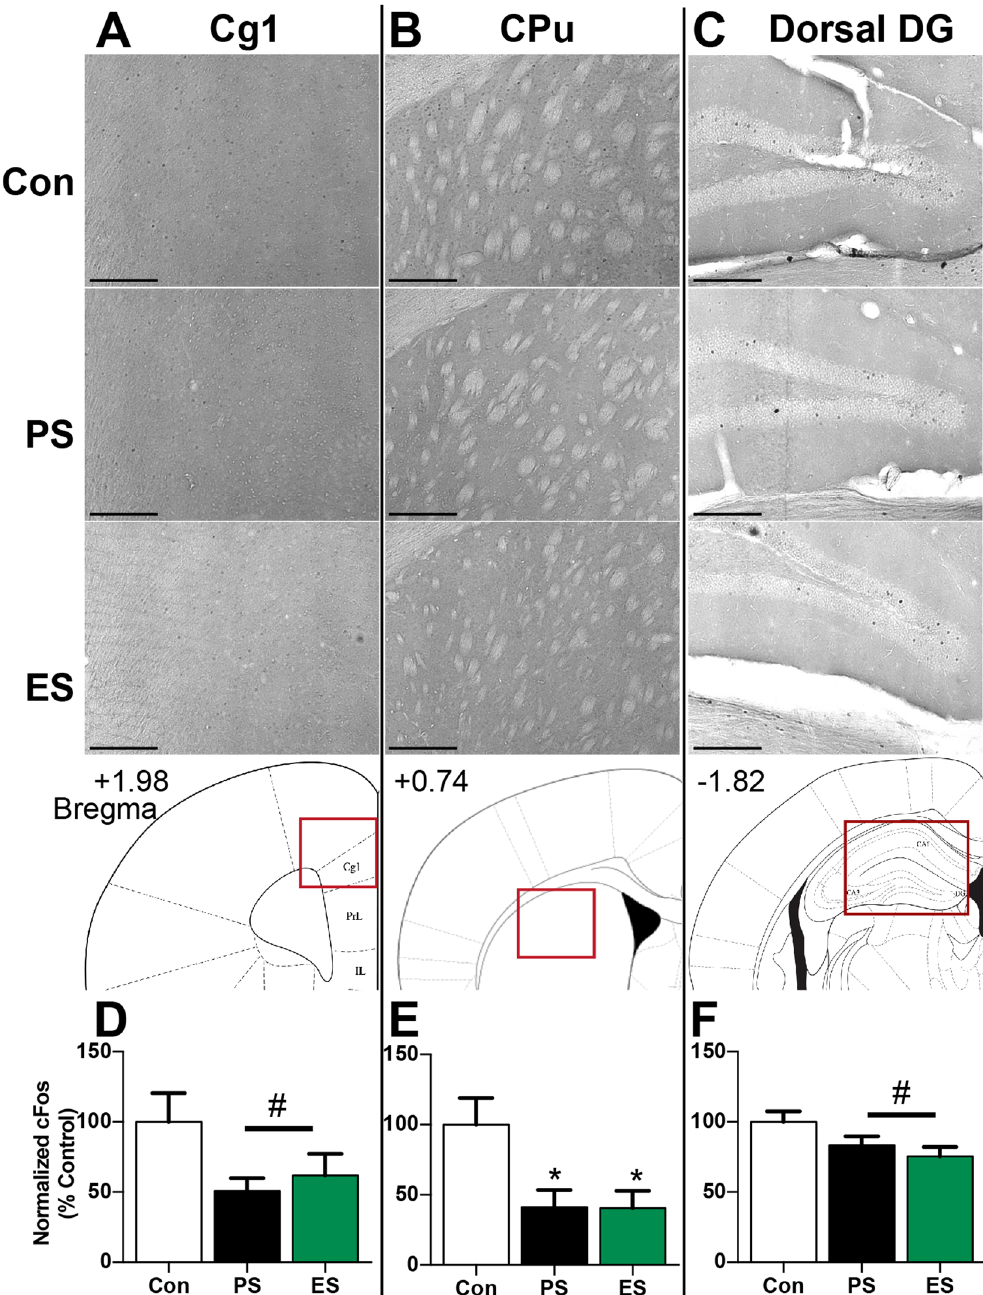
Figure 3. CSDS decreases the number cFos-positive cells in select brain regions. Top panel: Representative images of cFos-positive nuclei visualized by DAB-staining in control (Con), physical stress (PS), and emotional stress (ES) mice in ( A ) cingulate cortex (Cg1), ( B ) caudate putamen (CPu), ( C ) Dorsal dentate gyrus (DG) (Scale bar: 200 μ m). Schematics of the location of each brain region (red box) within a coronal slice are depicted below (adapted from ref. 36). ( D – F ) Quantification of the number of cFos-positive nuclei, displayed as percent of control. n = 9–12 mice/group, * p < 0.05 compared to control, Tukey’s post-hoc test, # non-significant